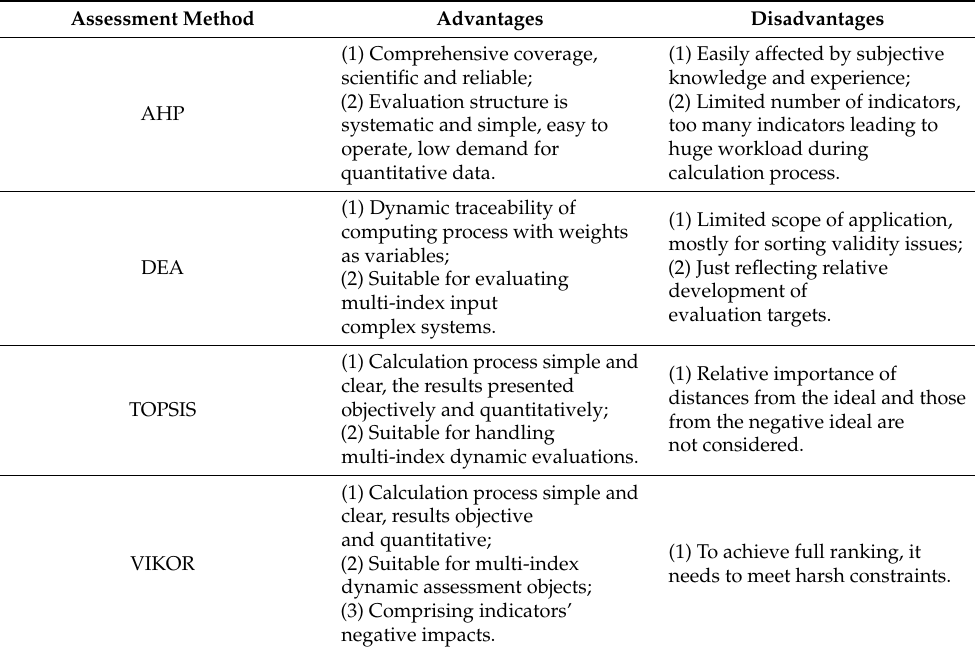
Table 2. Comparison table of common evaluation